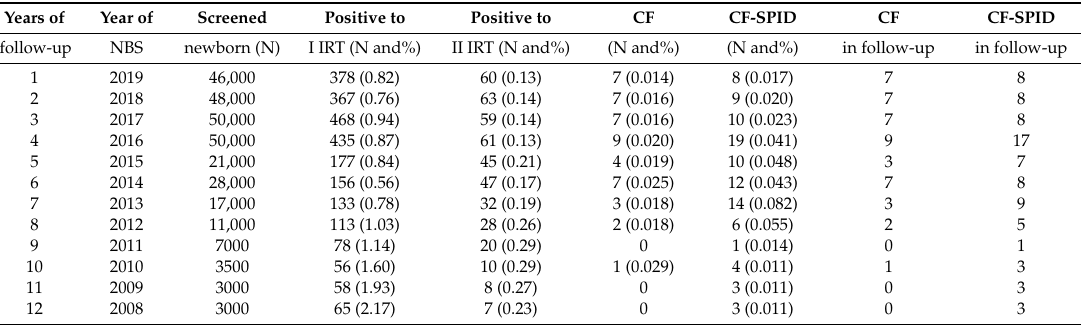
Table 2. Newborn screening (NBS) data (2008–2019).